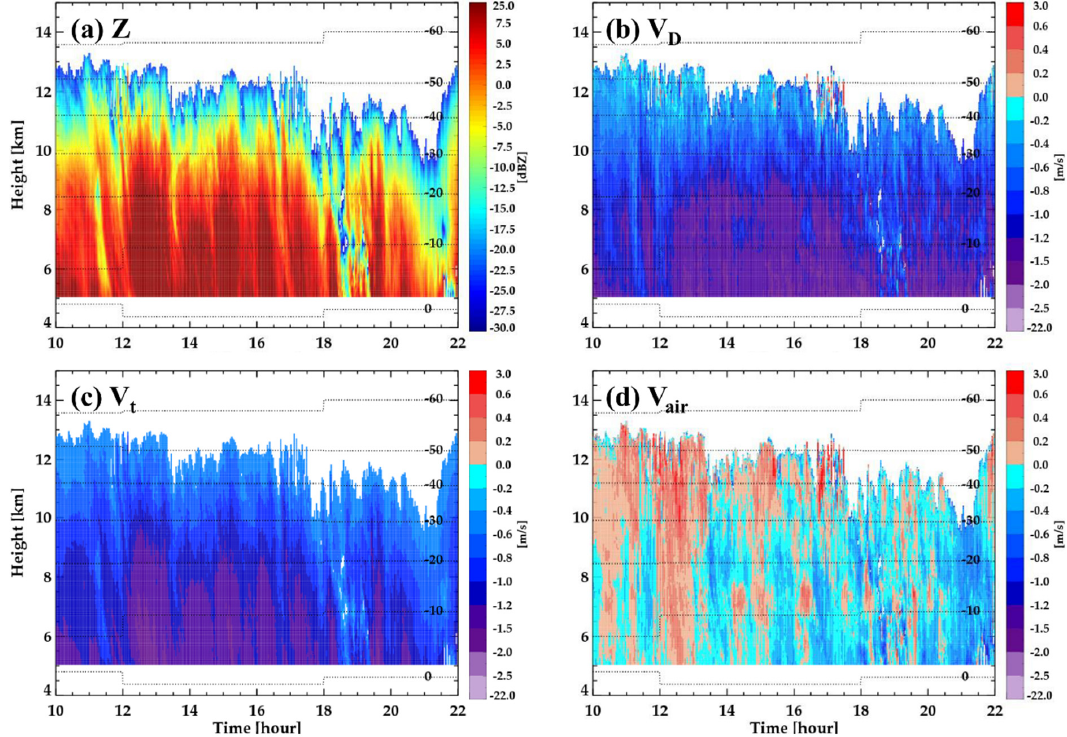
Figure 11. Time–height cross-sections of ( a ) observed Z , ( b ) observed V D , ( c ) V t retrieved from V t – Z relationship of stratiform, and ( d ) retrieved V air of a case of stratiform on 5 July 2014. Dotted line is temperature from sounding data.